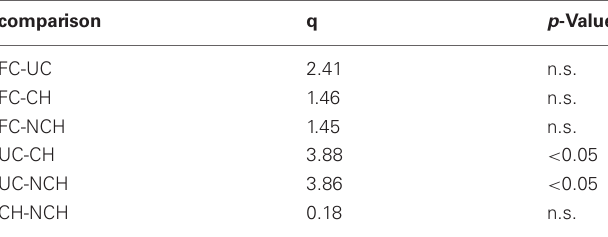
Table 2 | Pair-wise comparisons using Tukey–Kramer post-hoc